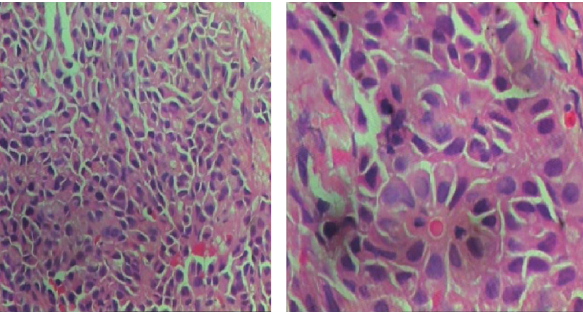
Figure 4: Histopathology showing a typical rosette appearance of neuroendocrine tumor.